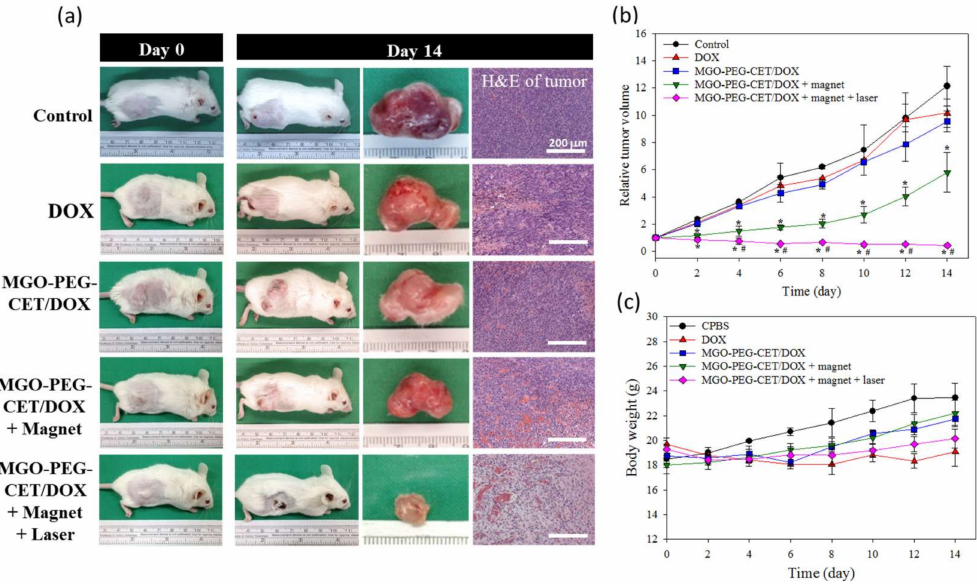
Figure 10. The anti-tumor efficacy in vivo with tumor-bearing BALB/C mice. BALB/c mice were subcutaneously implanted with CT-26 cells and were given different treatment by intravenous injection of normal saline (control), DOX, MGO-PEG-CET/DOX, MGO-PEG-CET/DOX + magnet, and MGO-PEG-CET/DOX + magnet + laser (30 mg/kg DOX). ( a ) The gross observation of tumor-bearing BALB/c mice on day 0 and 14, the gross view of incised tumor and the H&E staining of the incised tumor on day 14 (bar = 200 µ m); The relative tumor volume ( b ) and body weight ( c ) were recorded. * p < 0.05 compared with control, DOX, and MGO-PEG-CET/DOX, # p < 0.05 as compared with MGO-PEG-CET/DOX +